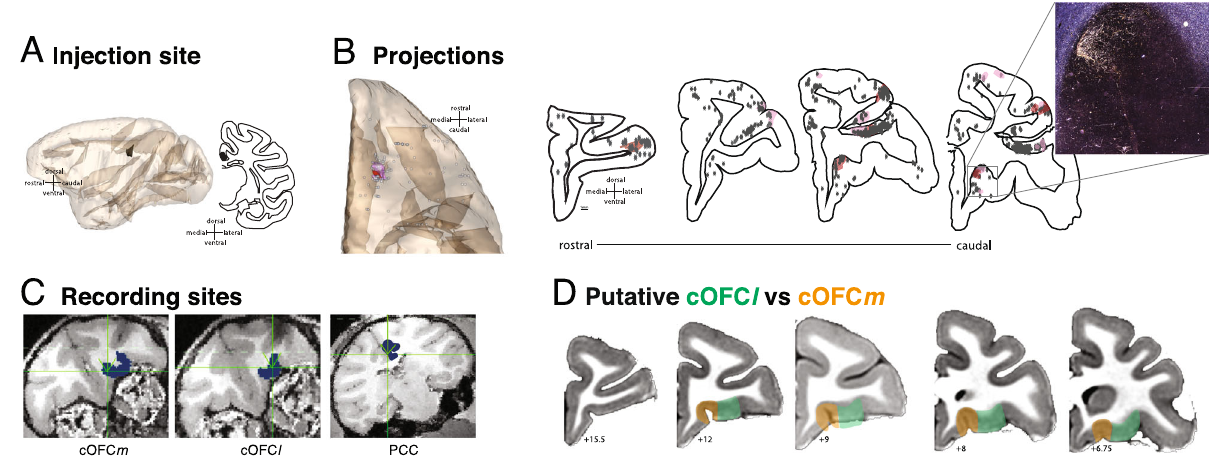
Fig. 1 Anatomical connectivity between cOFC and PCC and matching recording sites. A Injection site (black, Case M1FR) is rendered in 3D and shown in a sagittal view (left) and on a coronal slice (right). B Projections to the cOFC rendered in 3D and shown on an orbital view. Red indicates dense terminal fi elds; pink indicates light terminal fi elds; gray spheres are labeled cells. The majority of cOFC labeling is around the medial orbital sulcus. On the right, coronal slices with full PFC labeling, colors are as on the left. A photomicrograph indicates label around the medial orbital sulcus. C Coronal sections of example recording site from each of OFC, with cOFC m on left and cOFC l in the middle, and PCC. D Putative subdivisions of cOFC on coronal slices of an atlas brain 76